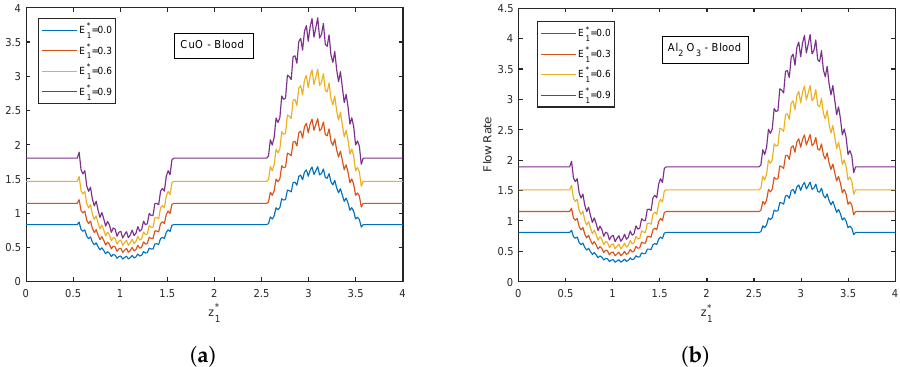
Figure 15. Flow rate profiles of electric field parameter E ∗ nanoparticles at t ∗ = 1